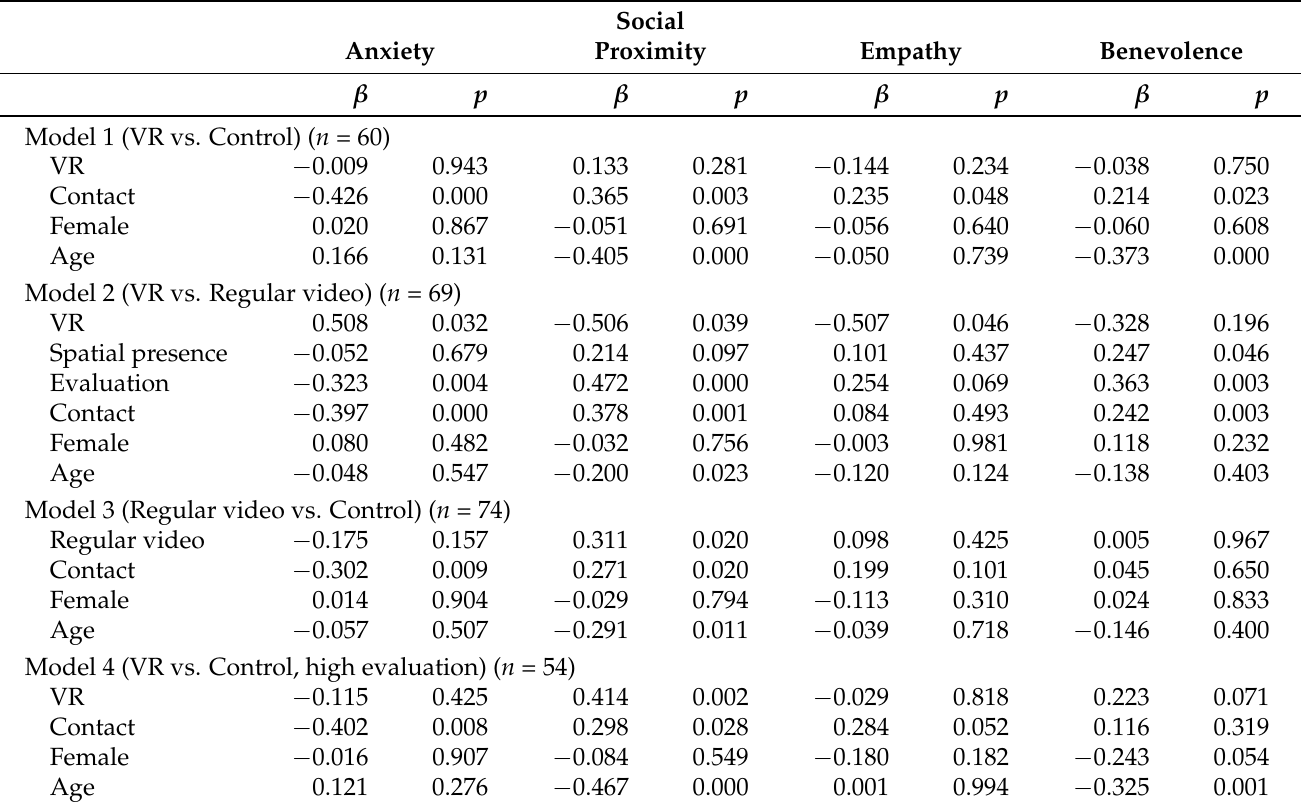
Table 1. SEM results for group difference, spatial presence, evaluation, contact, female gender, and age predicting anxiety, social proximity, empathy, and